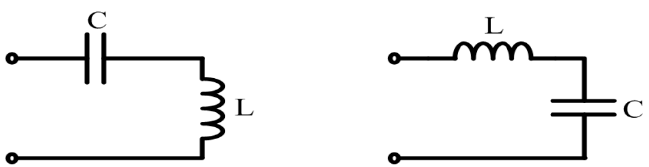
Figure 5. The used EIM networks.